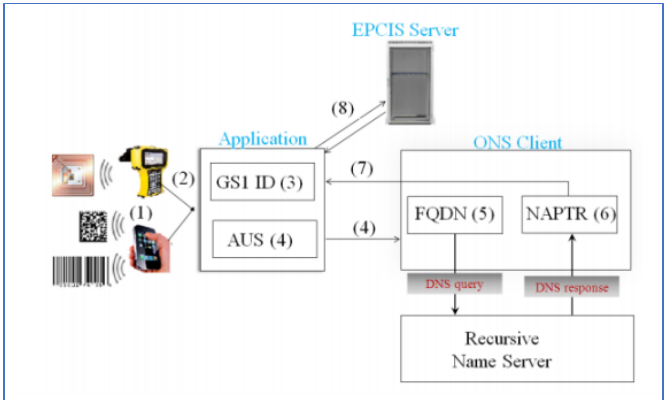
Figure 4. Illustration of query logic [61].